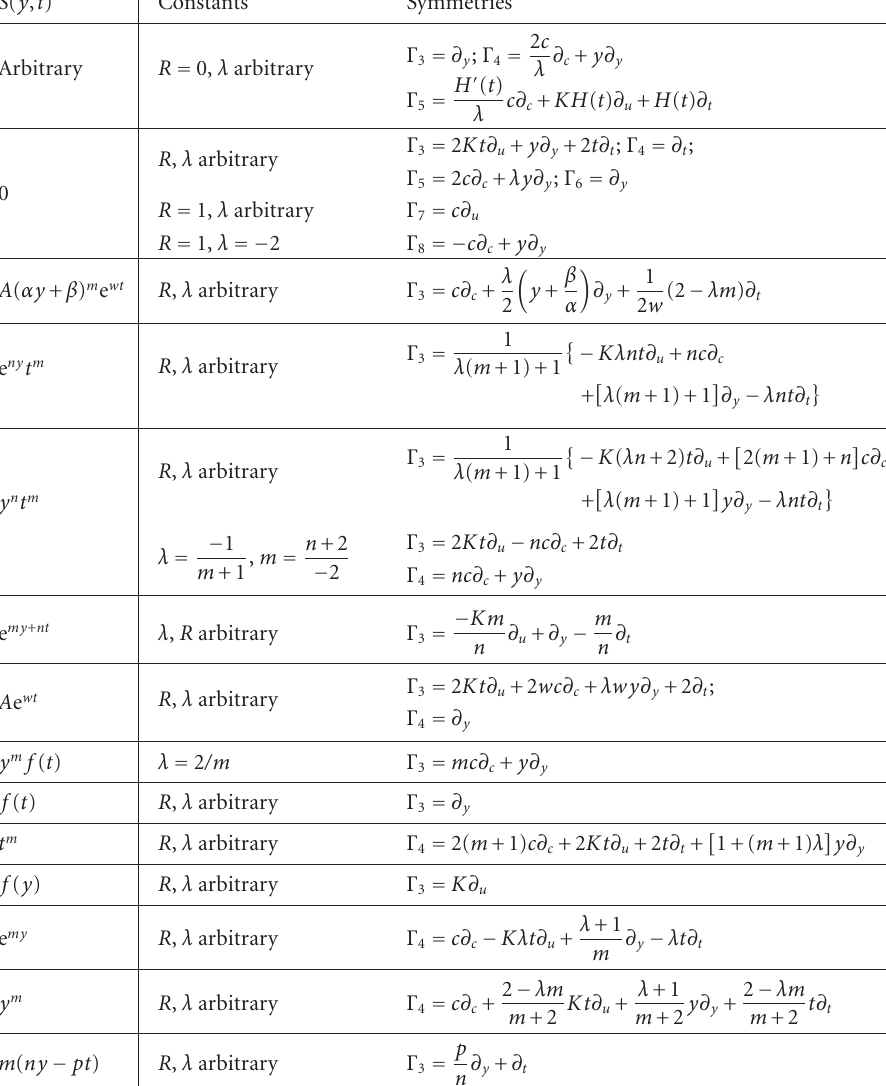
Table 3.1. Special cases of S ( y , t ) and extension of the principal Lie